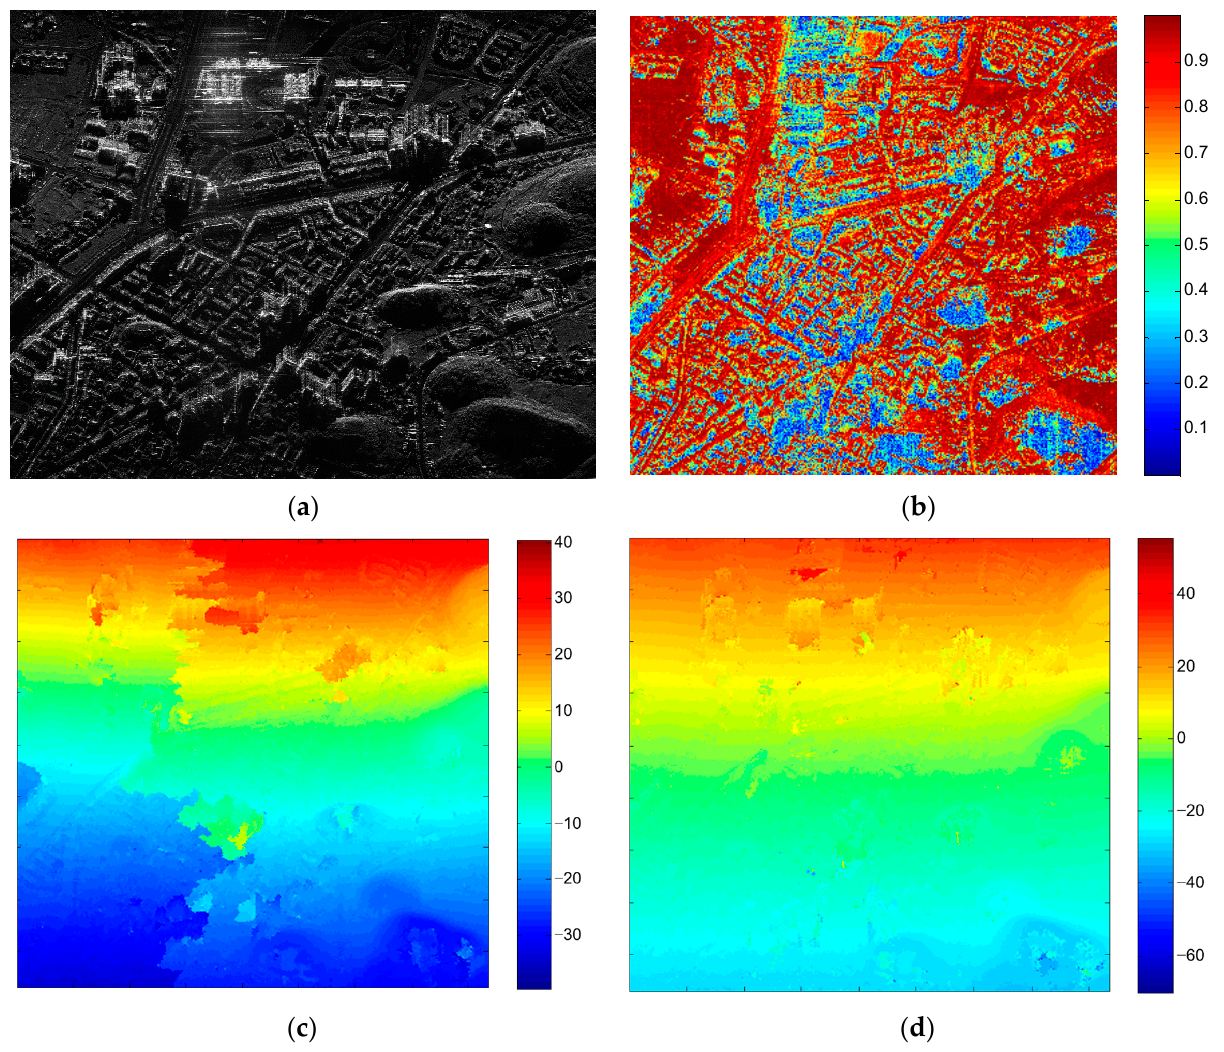
Figure 24. Phase processing and elevation inversion of data block containing urban area, where ( a ) is the amplitude image, ( b ) is coherence coefficient diagram, ( c ) is the result of conventional phase unwrapping and ( d ) is the correct phase unwrapping result.